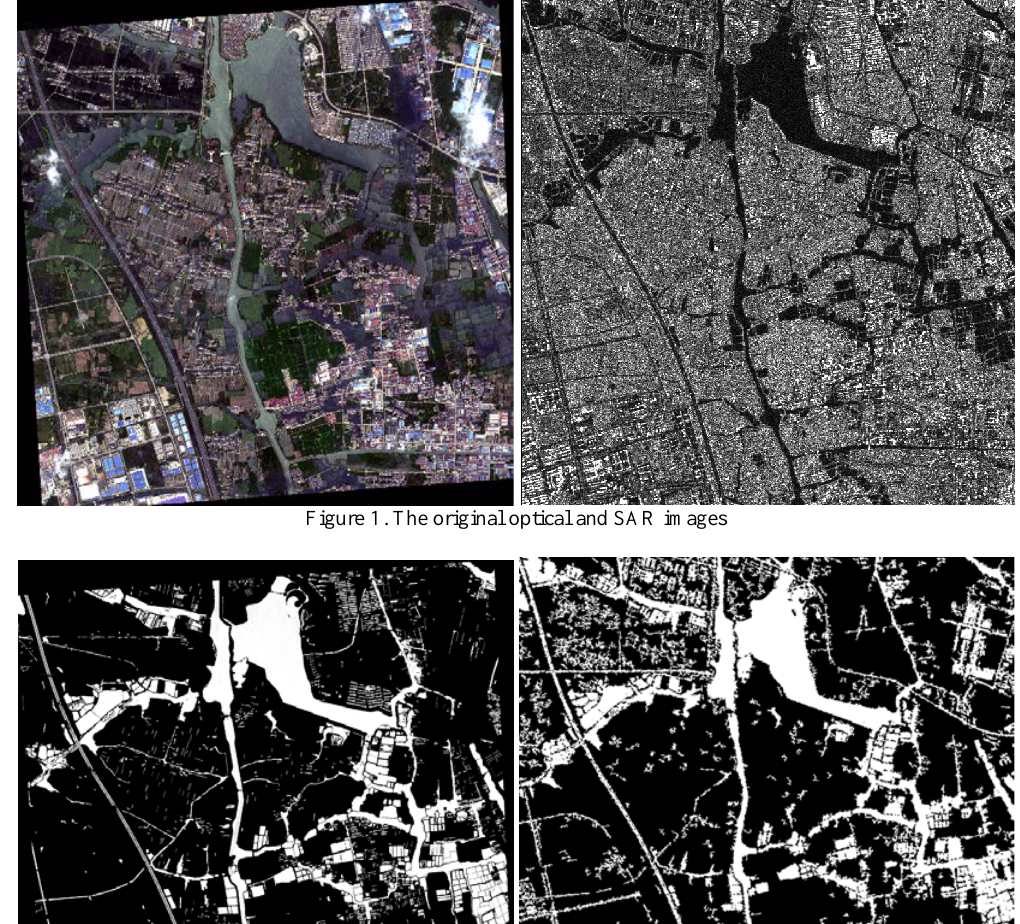
Figure 2. Closed regions extraction